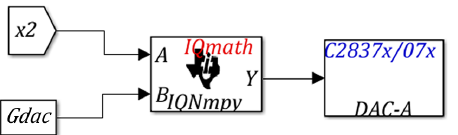
Figure 11. DAC Block: Used for showing state and internal variables in a scale between 0 V–3.3 V (12-bit resolution).